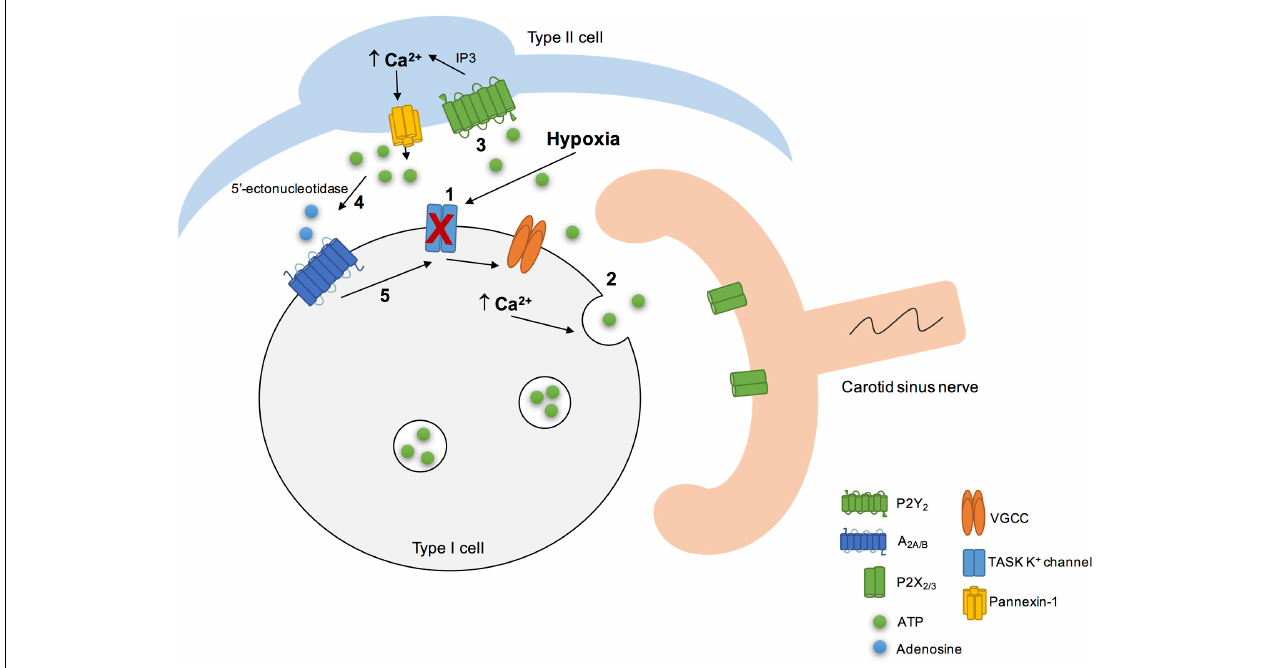
FIGURE 3 | Schematic representation of the CB “tripartite” synapse model proposed by Nurse and collaborators. Hypoxia induced type I cell depolarization through the inhibition of TASK1/3 K + channels (1), leading to Ca 2 + entry via voltage-gated Ca 2 + channels (VGCC) and to ATP release (2). ATP excites postsynaptic P2X 2 / 3 receptors on petrosal nerve terminal. ATP can also stimulate P2Y 2 receptors in adjacent type II cells (3), leading to the Ca 2 + release from intracellular stores via inositol triphosphate (IP3) signaling pathways and opening of pannexin-1 channels. This results in ATP release that could be break down by extracellular 5’ectonucleotidase into adenosine (4) (Conde et al., 2012a; Salman et al., 2017). Adenosine stimulates A 2A adenosine receptors in type I cells, leading to the inhibition of TASK1/3 K + channels, that enhance type I cell depolarization (5) (Xu et al., 2005) and, therefore ATP release. It is not represented but hypoxia stimulates adenosine release per se from type I cells (Conde and Monteiro, 2004) and high levels of ATP could inhibit pannexin-1 channels in type II cells and inhibit the chemoreceptor function via P2Y 1 receptors, through a negative feedback mechanism. Adapted from Zhang et al. (2012), Nurse (2014), Murali and Nurse